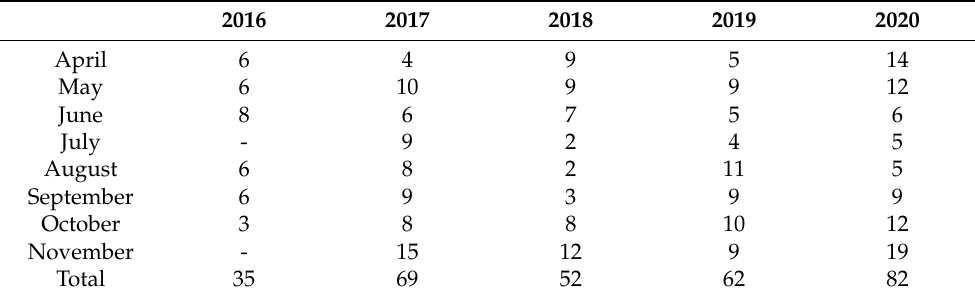
Table 1. Image-selection schedule.